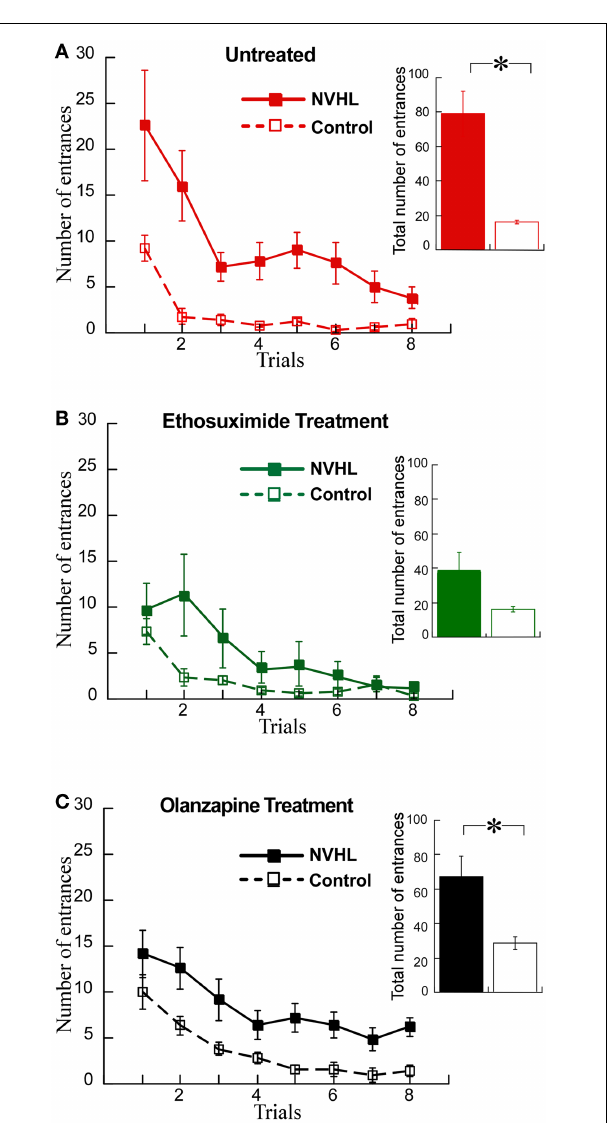
FIGURE 8 | Ethosuximide attenuated the cognitive control impairment of NVHL rats . (A) In the untreated group, the NVHL rats were slower to learn the two-frame task and showed an impairment when compared to the control rats (learning curve: two-way repeated-measures ANOVA group: F 1,64 = 53.84, p < 0.0001; trial: F 7,64 = 8.80, p < 0.0001; interaction: F 7,64 = 1.79, p = 0.10); inset: total number of entrances: t 8 = 4.69, p = 0.002). (B) Ethosuximide treatment attenuated the learning impairment in the NVHL rats when compared to control rats (learning curve: two-way repeated-measures ANOVA group: F 1,64 = 5.86, p = 0.02; trial: F 7,64 = 9.79, p < 0.0001; interaction: F 7,64 = 2.40, p = 0.03); inset: total number of entrances: t 8 = 1.87, p = 0.10). (C) Olanzapine treatment did not improve performance of the NVHL rats on the two-frame task (learning curve: two-way repeated-measures ANOVA group: F 1,64 = 42.87, p < 0.0001; trial: F 7,64 = 9.66, p < 0.0001; interaction: F 7,64 = 0.19, p = 0.99); inset: total number of entrances: t 8 = 3.10, p =